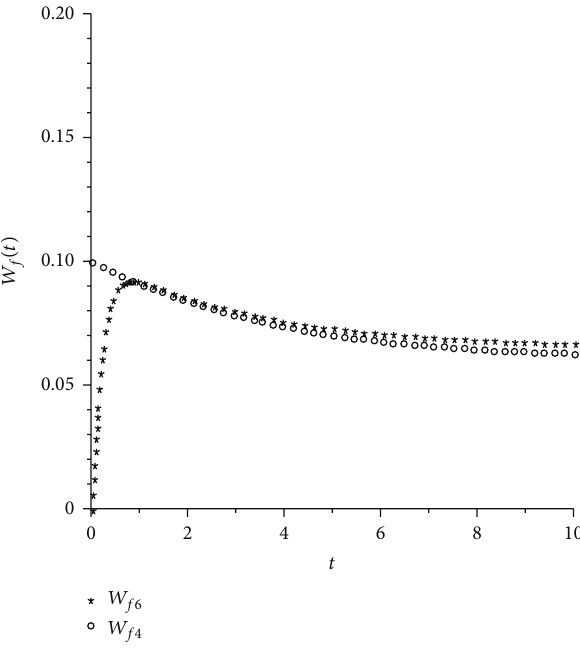
Figure 9: Instantaneous failure frequencies of the systems with and without warning device with 𝛼 = 5 .